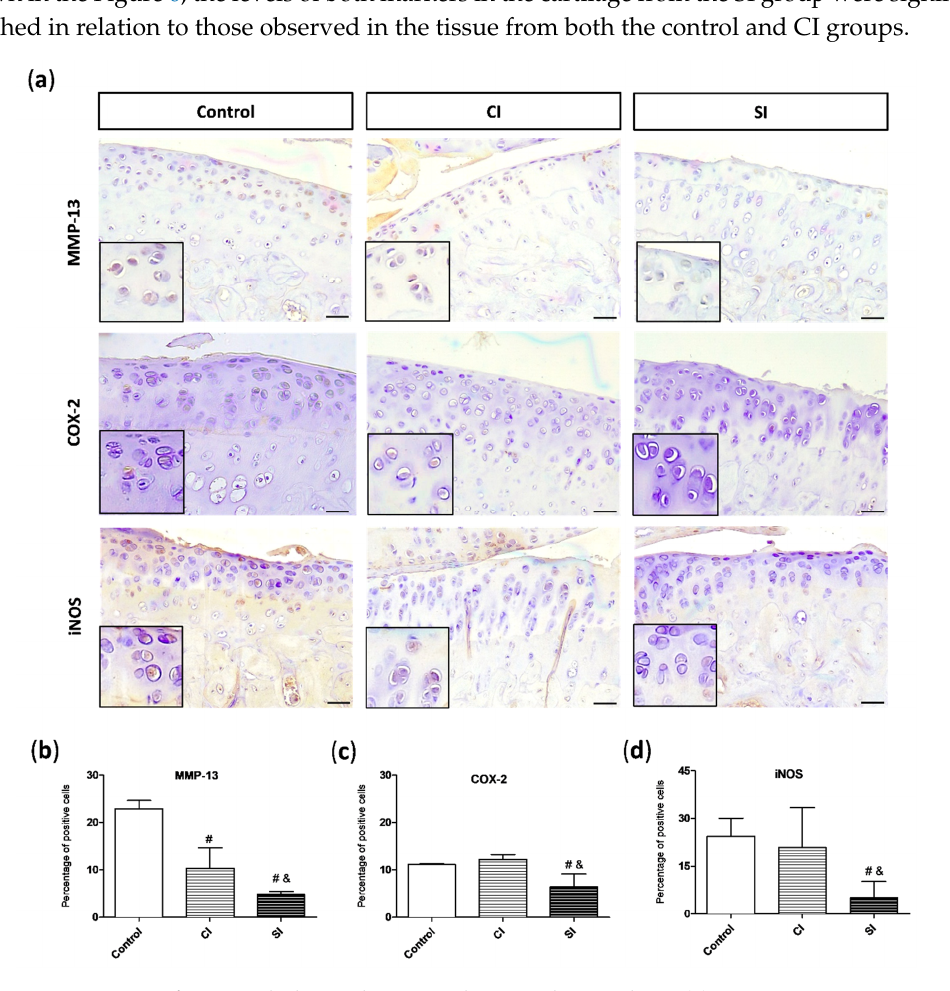
Figure 6. Presence of pro-catabolic mediators in the articular cartilage. ( a ) Representative images of metalloproteinase-13 (MMP-13), inducible nitric oxide synthase (iNOS), and cyclooxygenase 2 (COX-2) immunohistochemistry in the cartilage from each group of study. Magnifications (2x) of the images are shown on their bottom-left corners. Quantitative analysis of MMP-13 ( b ), iNOS ( c ), and COX-2 ( d )-positive cells. Values are mean ± SEM ( n = 3 independent animals for each condition). & p ≤ 0.05 vs. the C group; # p ≤ 0.05 vs. the CI group. Control, non-treated; CI, control injection; SI, H 2 S donor injection. Scale bar = 50 µm.